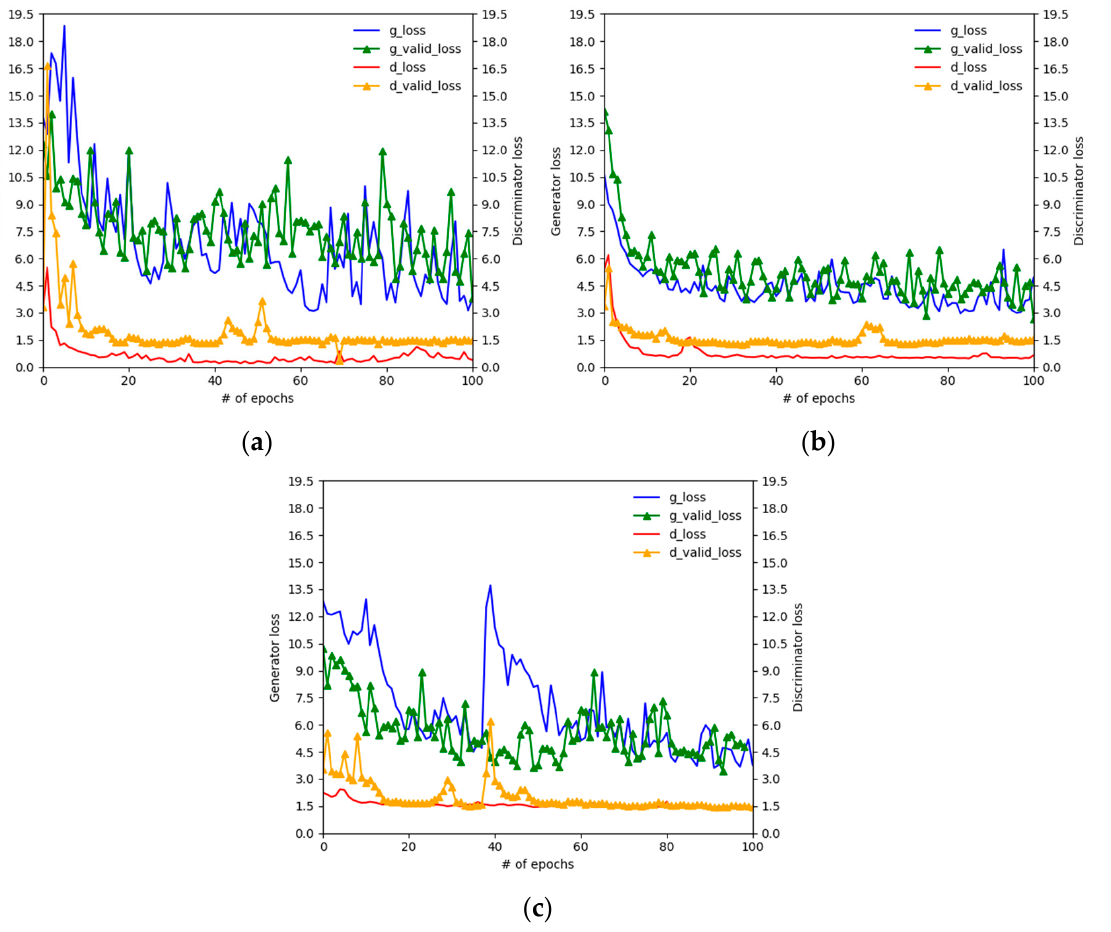
Figure 3. Graphs of training losses of generator (g_loss) and discriminator (d_loss) by OSRCycleGAN with ( a ) CASIA-Iris-Distance, ( b ) CASIA-Iris-Lamp, and ( c ) IIT Delhi iris databases.